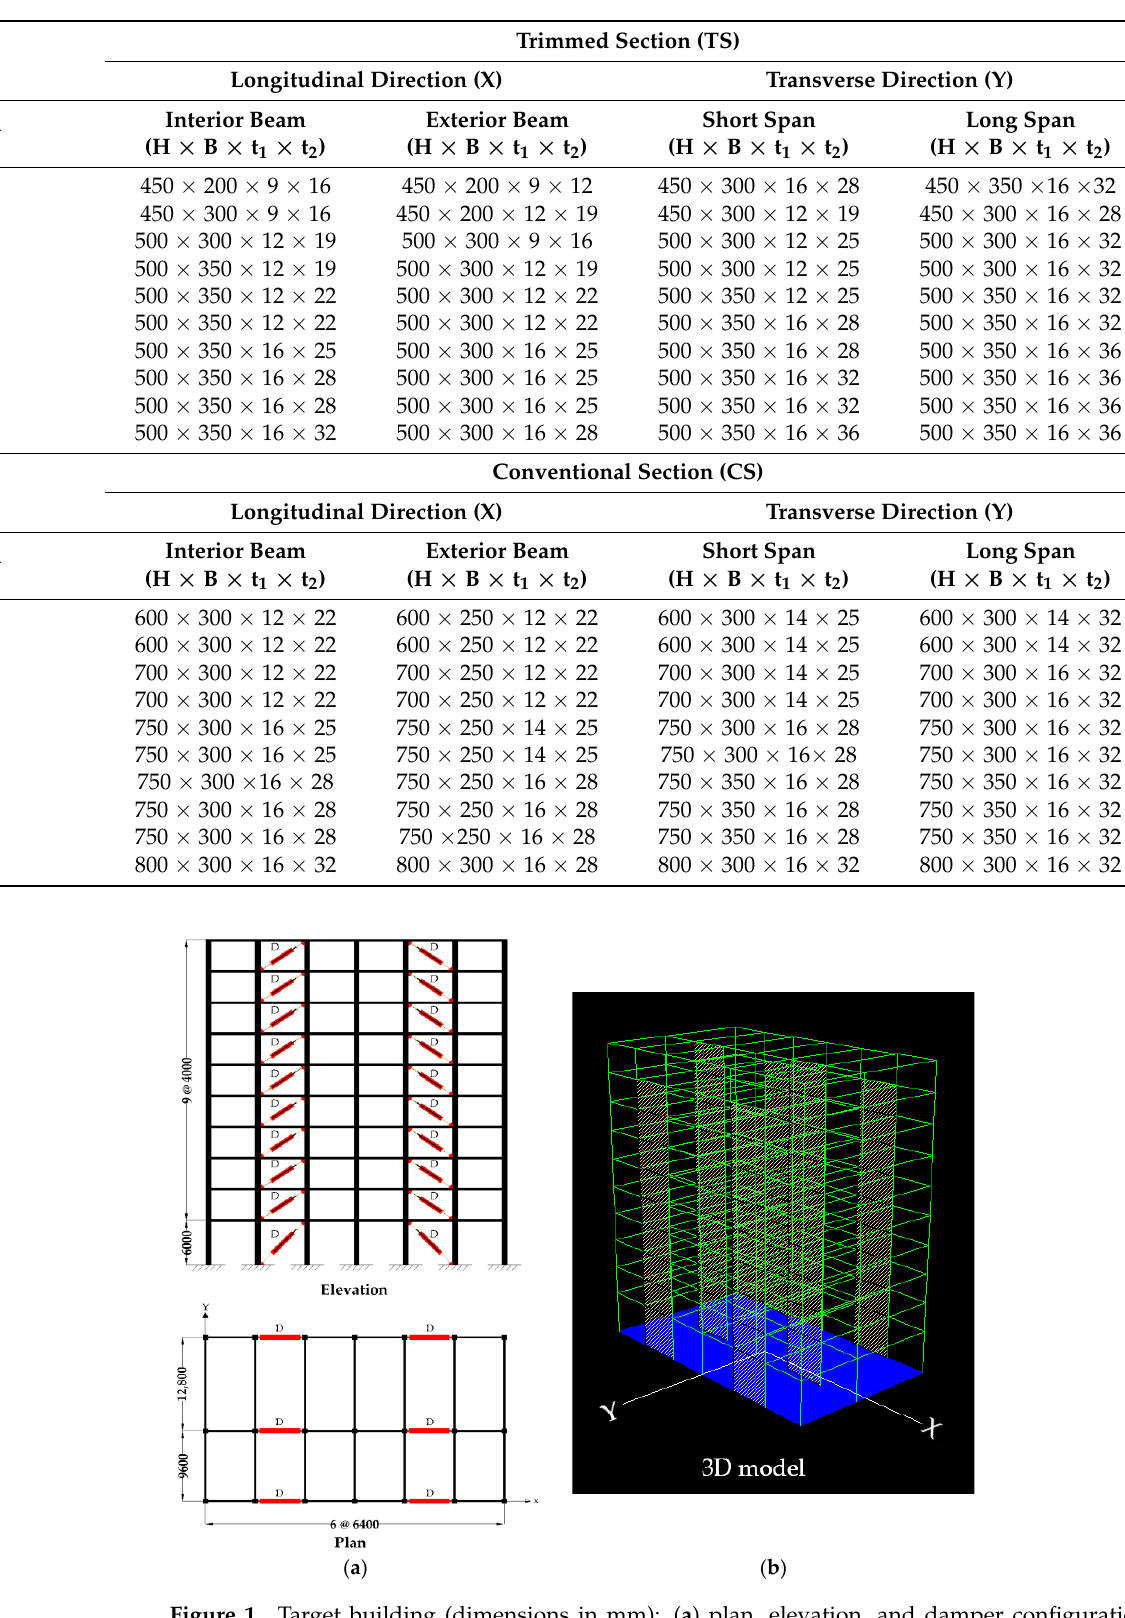
Table 3. Structural beam dimensions (mm).